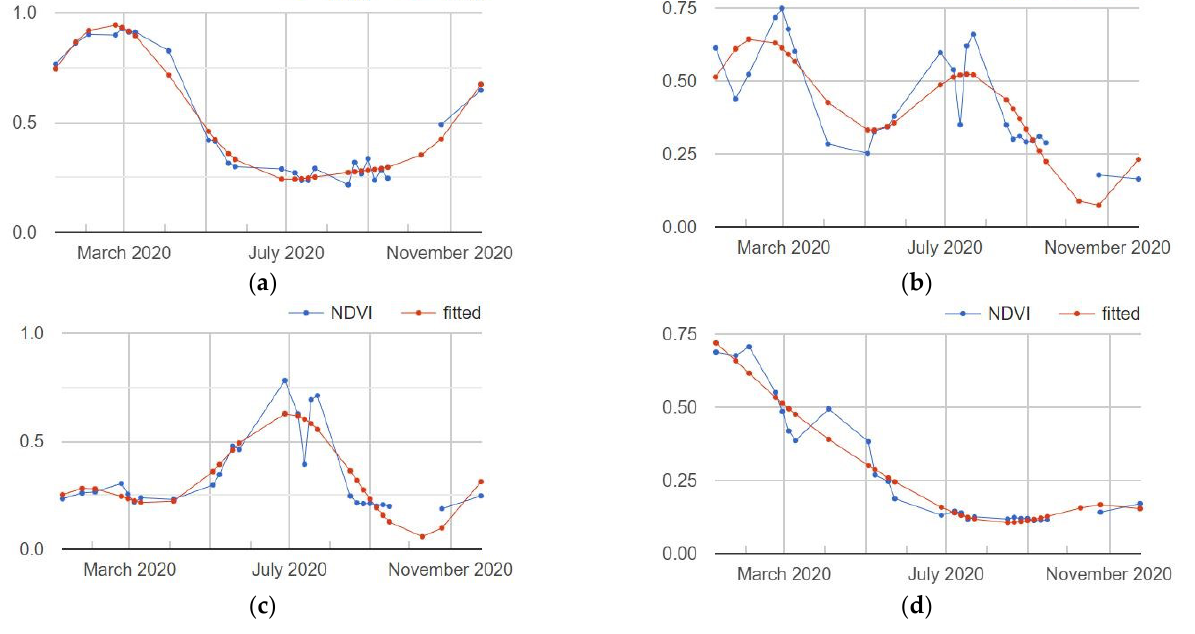
Figure 4. NDVI time series (blue line and dots) and harmonic fit (red line and dots) of defined annual crop categories for: spring crops ( a ), double cropping ( b ), summer crops ( c ), and winter crops ( d ).